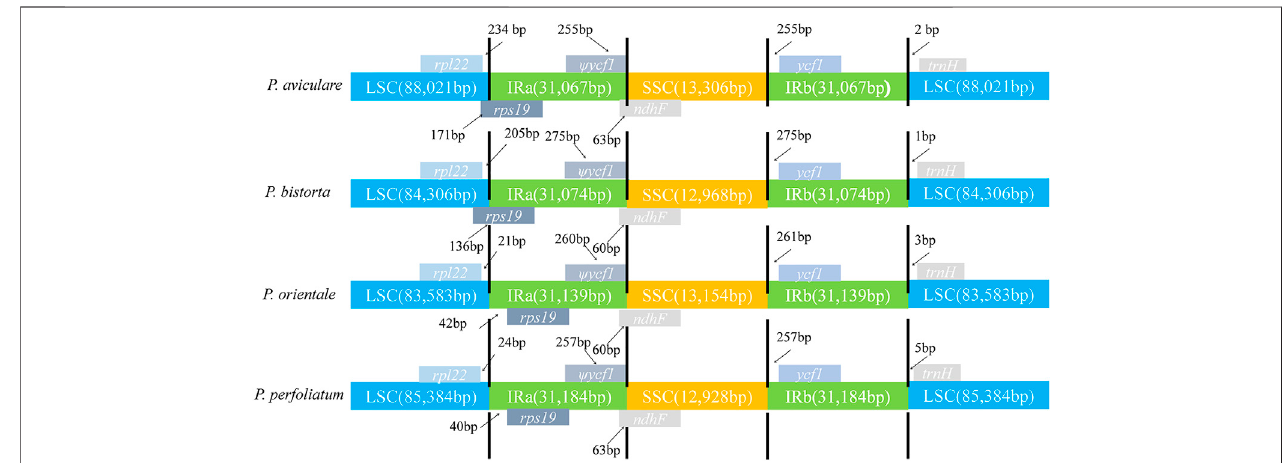
FIGURE 6 | Comparison of the chloroplast genome boundaries in four Polygonum cp genomes.